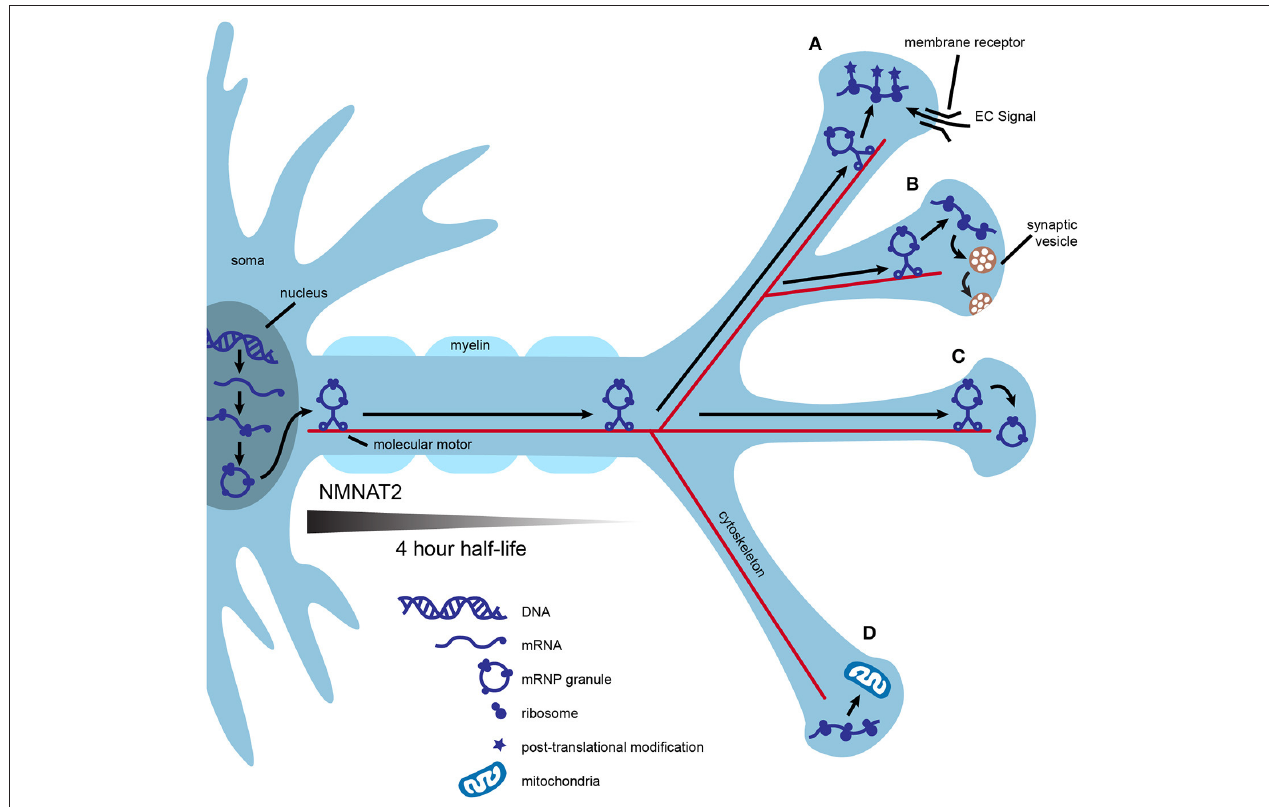
FIGURE 1 | Local translation may contribute to axonal efficiency and compartmentalization. mRNA is transcribed in the nucleus, packaged into mRNP granules, and transported by multiple molecular motors down the axon. Granules are transported into some synapses and mRNA is immediately translated into polypeptides (A,B) . Nascent polypeptides may present the opportunity for unique post-translational modification, as in synapse (A) or may be used to fulfill specific activity-based needs of individual synapses, as in (B) . Local translation of some mRNAs may be controlled at the synaptic level by the interaction of local extracellular signals, such as neurotrophins, with membrane receptors (A) . Alternatively, mRNP granules can be transported into synapses and stored for later use (C) , or excluded from other synapses (D) . Local translation of mitochondrial proteins could help to maintain a healthy supply of axonal mitochondria (D) . Axonal survival factors may also be translated locally. For example, NMNAT2 has a half-life of 4 h, and even if transported via fast axonal transport, would not make it to the most distance synapses before significant